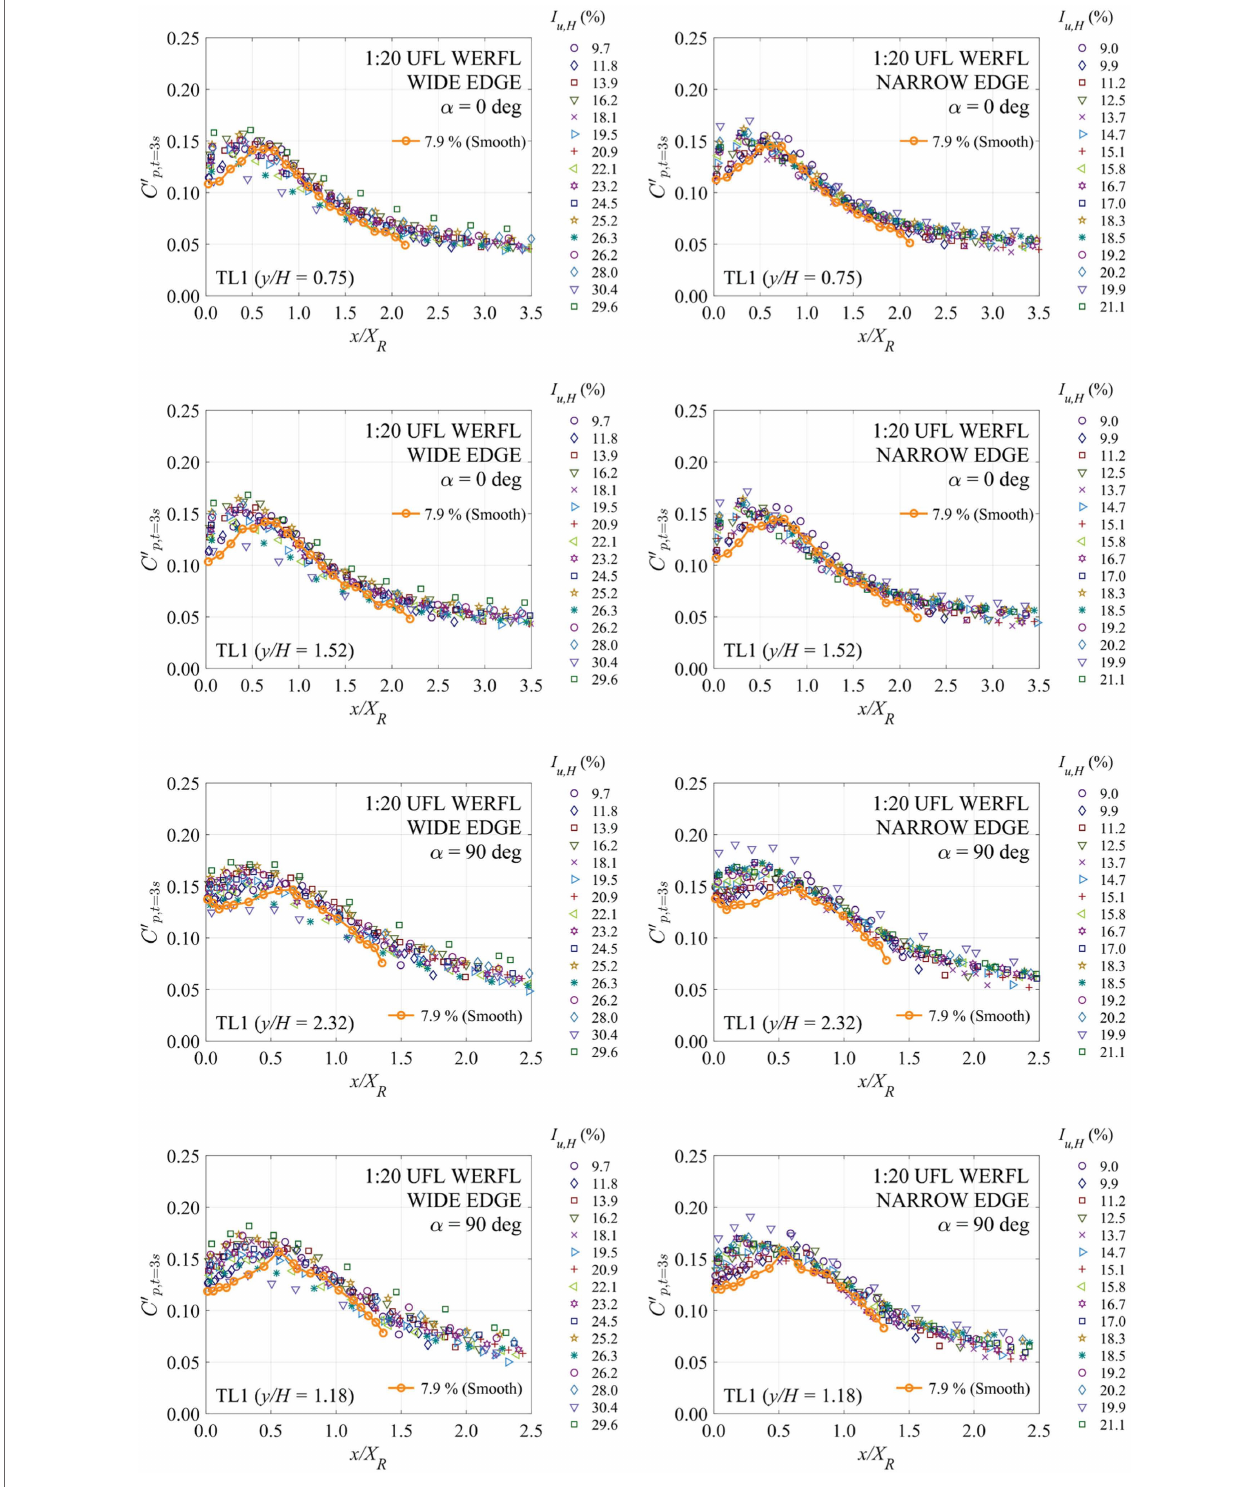
FIGURE 15 | Standard coefficient transects for the narrow (left column) and wide (right column) roughness element orientations normalized by the gust velocity pressure at eave height using a non-Gaussian peak factor model (Kareem and Zhao, 1994).